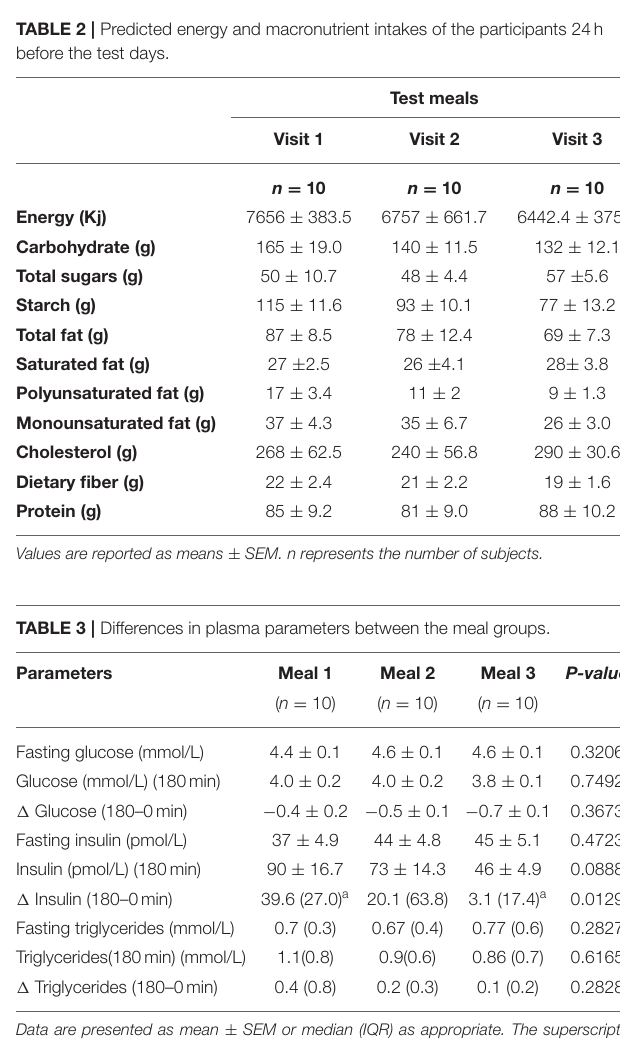
TABLE 2 | Predicted energy and macronutrient intakes of the participants 24h before the test days.